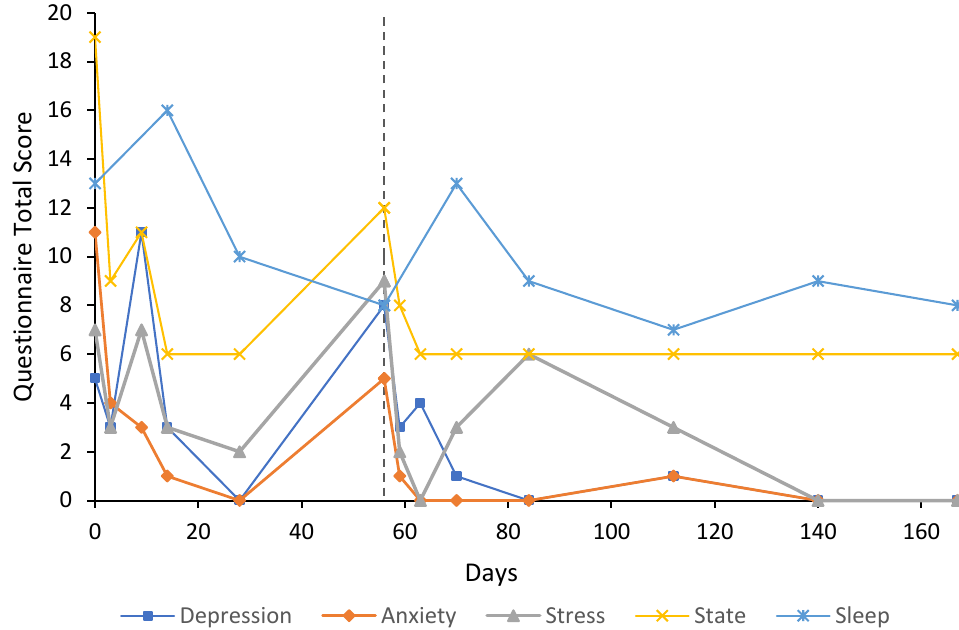
Figure 2. Line graph showing Case 2 results from the DASS-21 (depression, anxiety, and stress subscales), SSAI-6, and JSS at each follow-up. The participant was treated with an eight-day flumazenil infusion and re-treated on day 56 with a four-day flumazenil infusion (denoted by dashed line). Case 3 was a 64-year-old male, retired paramedic, with a 15-year history of GAD with treatment resistance. The participant also had a historic diagnosis of posttraumatic stress disorder with persistent residual symptoms. Previously, the participant had trialled agome- latine and amitriptyline; however, both were ineffective, and amitriptyline was ceased due to mood side effects of increased anxiety, anger, and irritability. Sleep was disturbed; the participant was waking nightly around 3 a.m. with anxiety and was unable to go back to sleep. Temazepam was briefly trialled approximately five months prior to the baseline assessment but the participant was reluctant to continue with this. The participant was tak- ing CoQ10, vitamin D3, magnesium, zinc, vitamin B12, and ashwagandha. Baseline anxiety and stress scores were low at baseline, despite describing significant anxiety symptoms. Anxiety and stress subscale scores were mild (4) and normal (5), respectively (Figure 3).